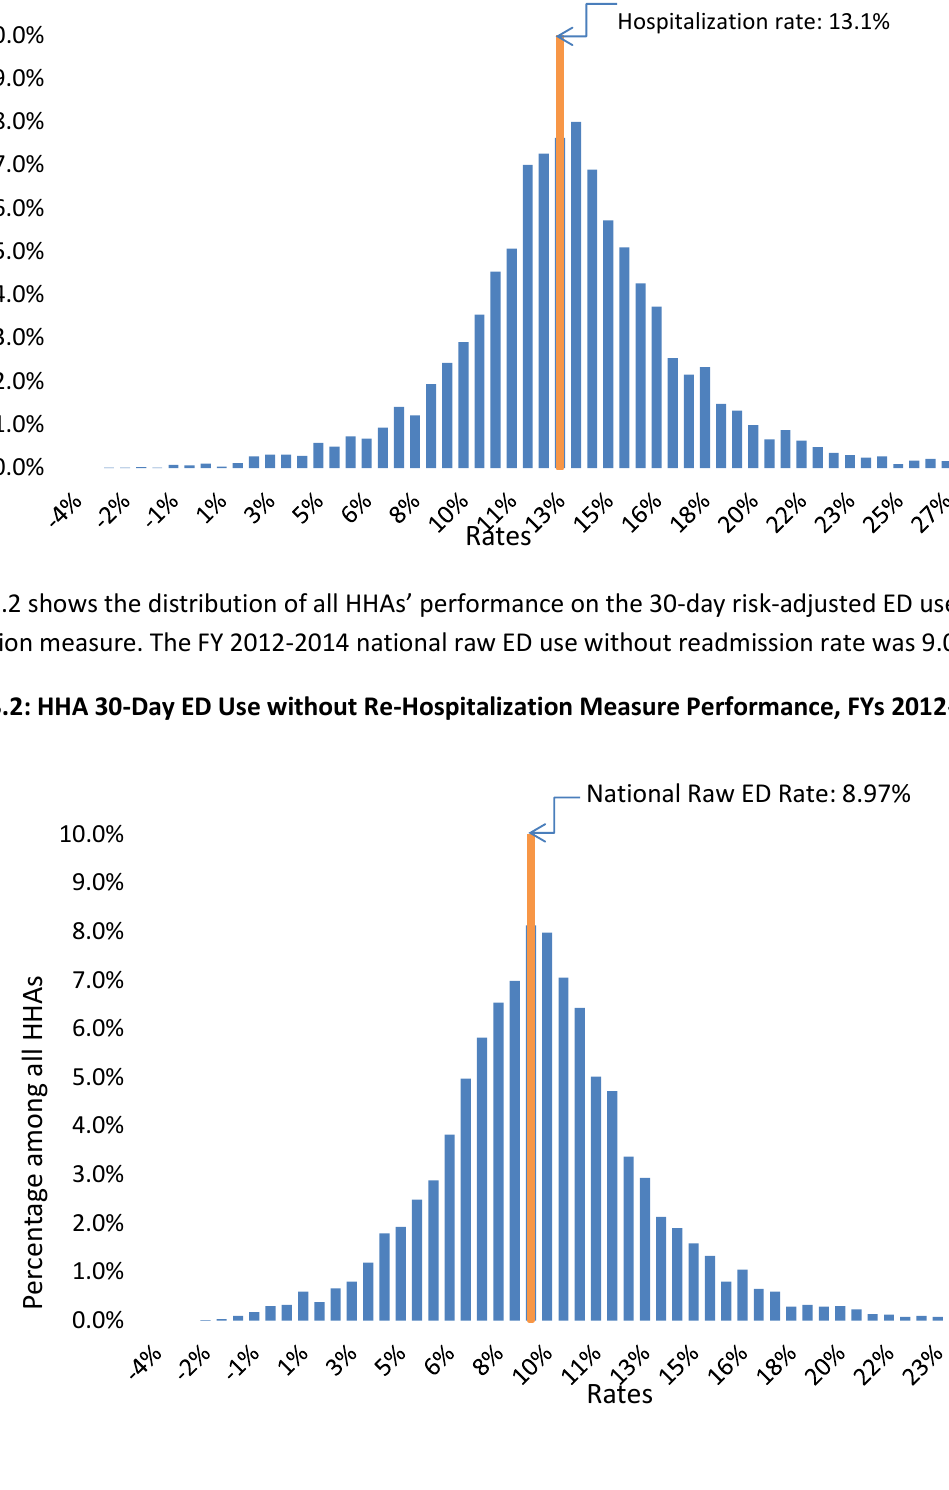
National Raw Mean Re- Hospitalization rate: 13.1%